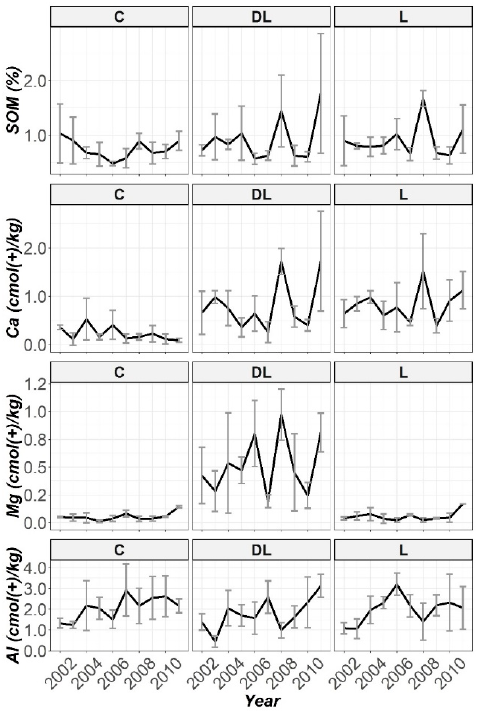
Figure 4. Temporal evolution of SOM, Ca, Mg and Al in the AB horizon throughout the ten years of soil monitoring (2002–2011).